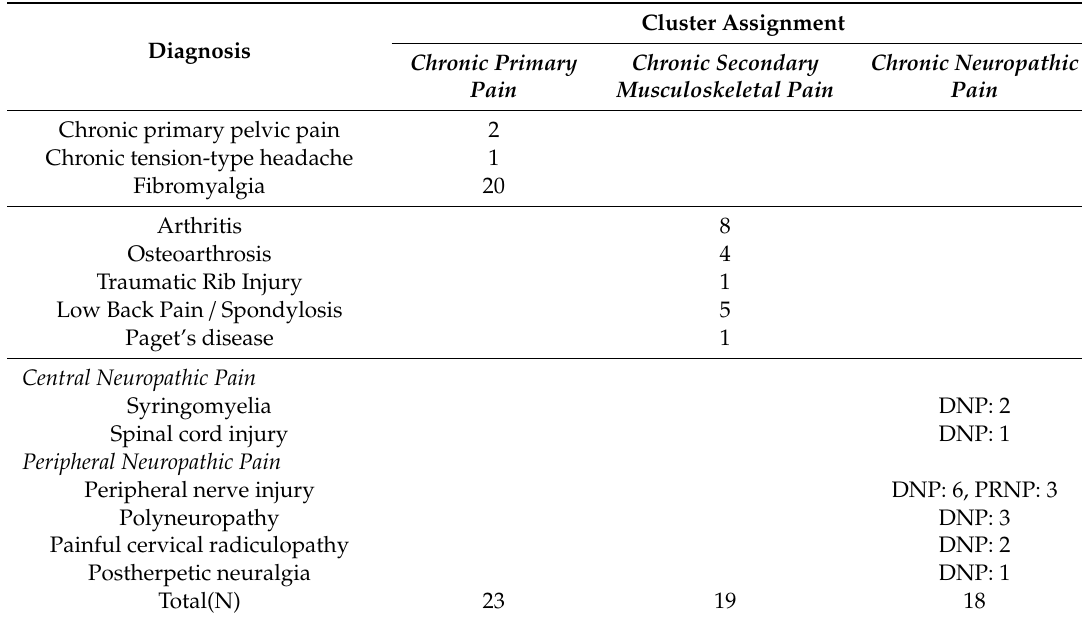
Table 1. CP pathologies and cluster